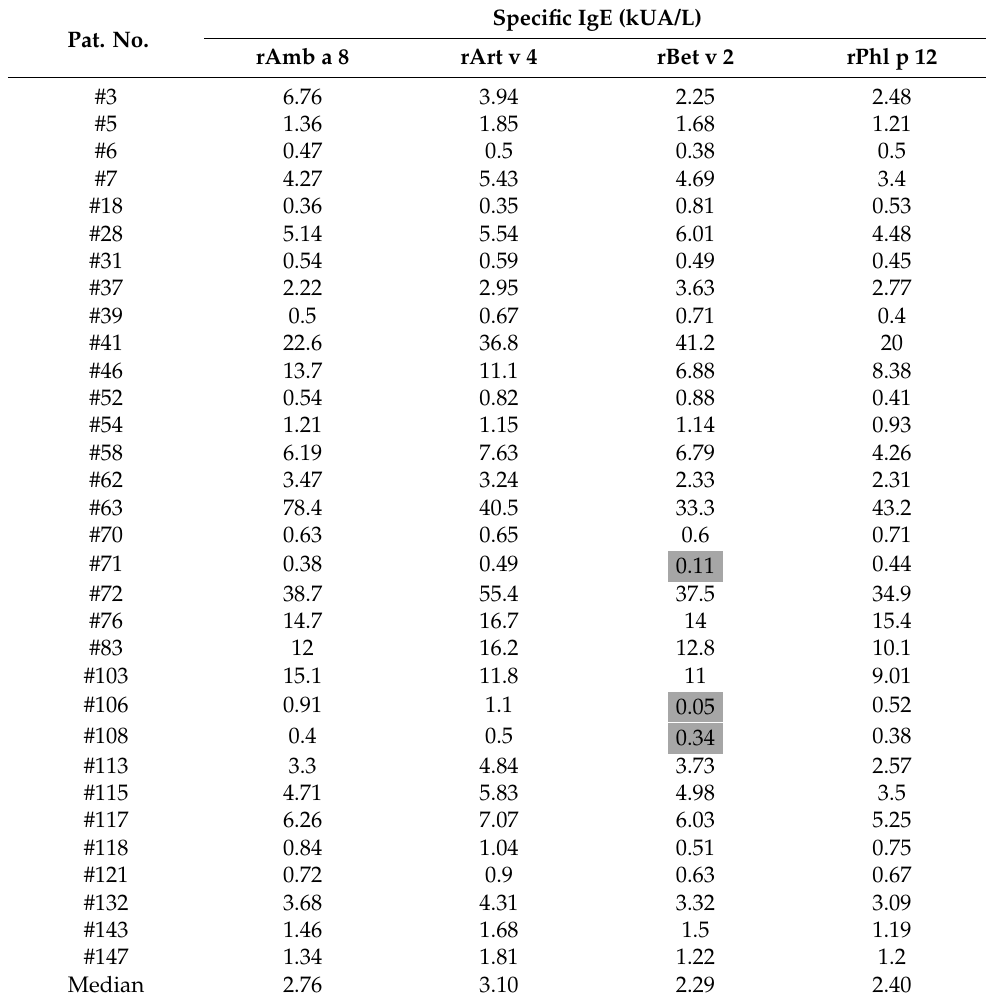
Table 2. ImmunoCAP measurement of sIgE (kUA/L) against profilins rAmb a 8 (ragweed), rArt v 4 (mugwort), rBet v 2 (birch) and rPhl p 12 (timothy grass) ( n = 32). Pat.